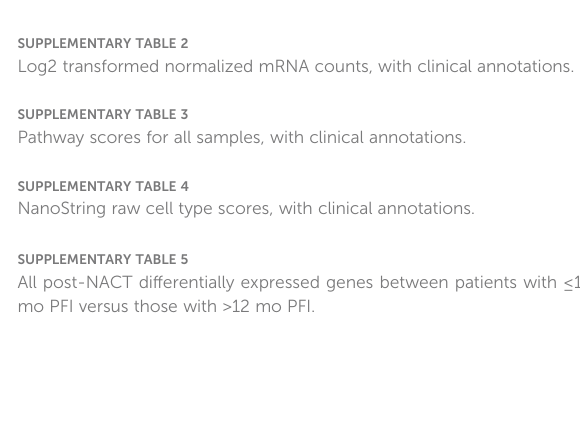
SUPPLEMENTARY TABLE 2 Log2 transformed normalized mRNA counts, with clinical annotations. SUPPLEMENTARY TABLE 3 Pathway scores for all samples, with clinical annotations. SUPPLEMENTARY TABLE 4 NanoString raw cell type scores, with clinical annotations.